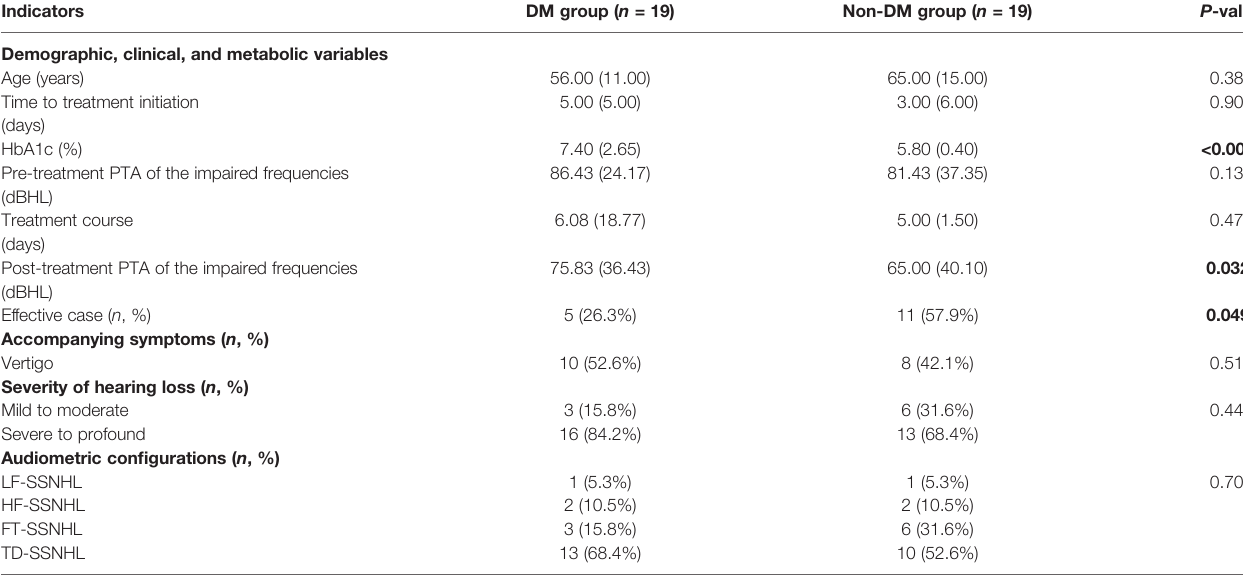
TABLE 3 | Prognosis conditions of SSNHL in the matched data set after propensity score matching using prognosis-related factors of SSNHL as the predictors.